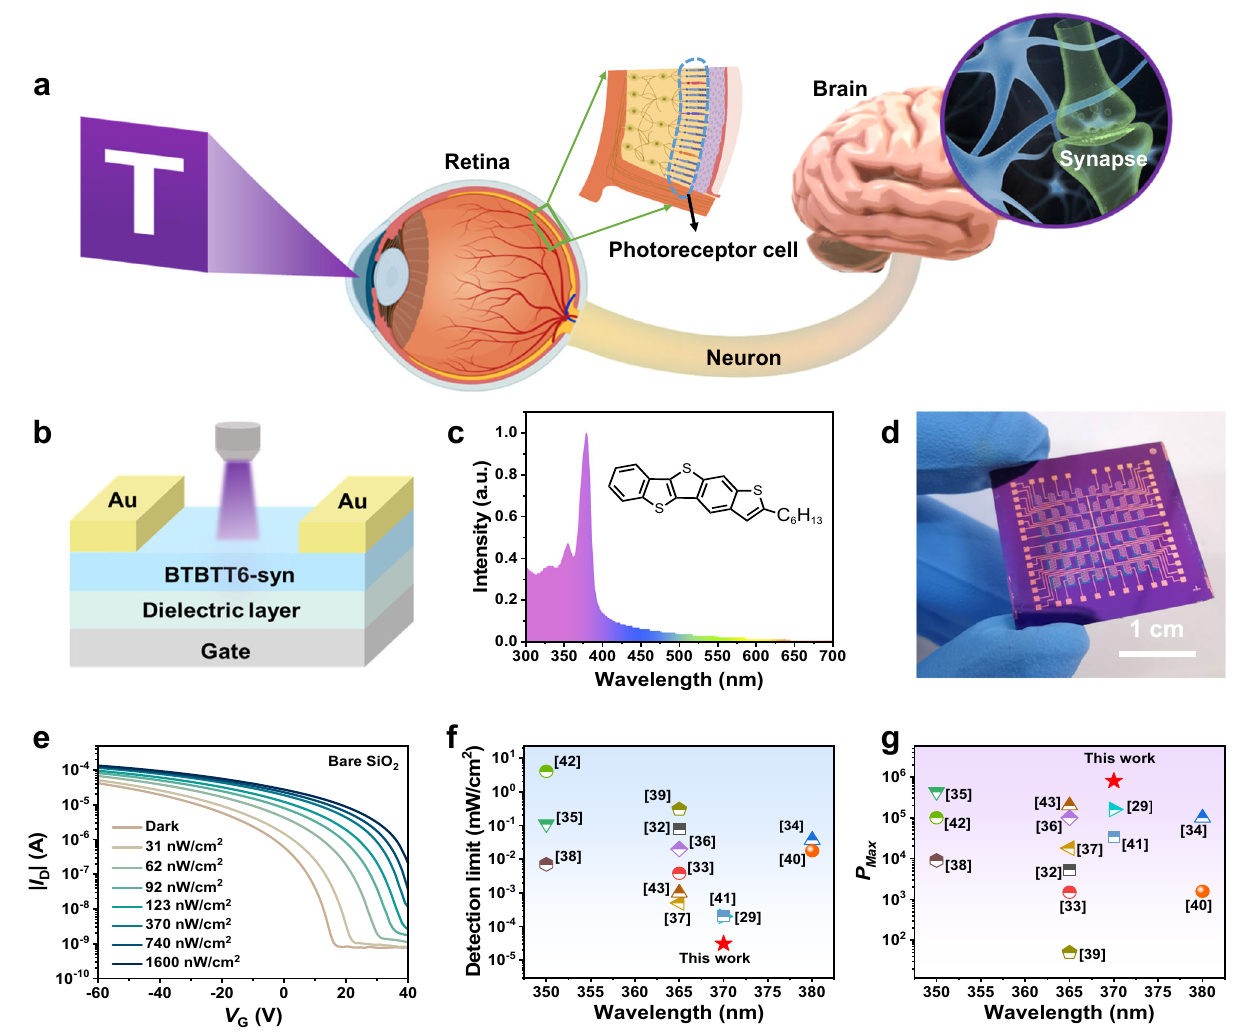
Fig. 1 | The UV-ultrasensitive neuromorphic vision sensor that uses organic phototransistors. a The arti fi cial vision system composed of a sensing unit, a memory unit and a processing unit. b The schematics of neuromorphic vision organic sensor. c UV-vis absorption spectra for BTBTT6-syn; inset: chemical structure of BTBTT6-syn. d The 6×8 patterned device array. e The transfer curves